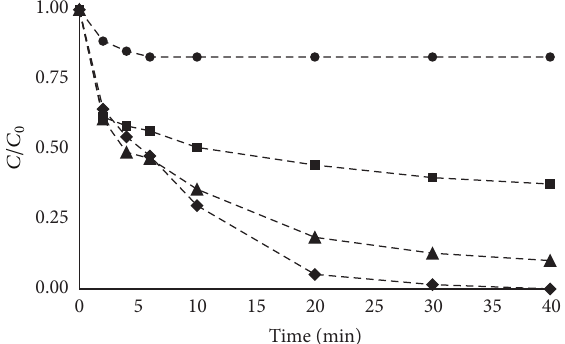
Figure 4: Normalized concentration profile as a function of pH from acid green 50 (4 × 10 −5 molL −1 ) solutions by Fenton process, using 37.4mg/g Fe 2 O 3 catalyst, combined with UV and Us irradia- tion (catalyst annealed at 500 ∘ C). X pH 2, 󳵳 pH 3, ◼ pH 5, and e pH